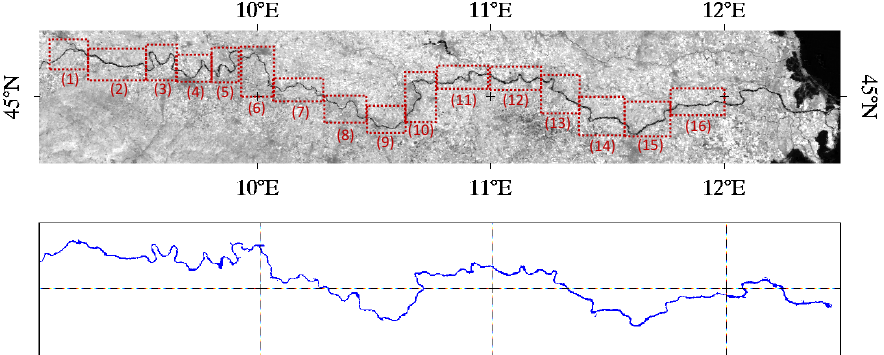
Figure 5. (Top panel) A MODIS image of the Po river with the selected river reaches. (Bottom panel) River mask extracted applying the proposed method by [38]. Date: 28 July